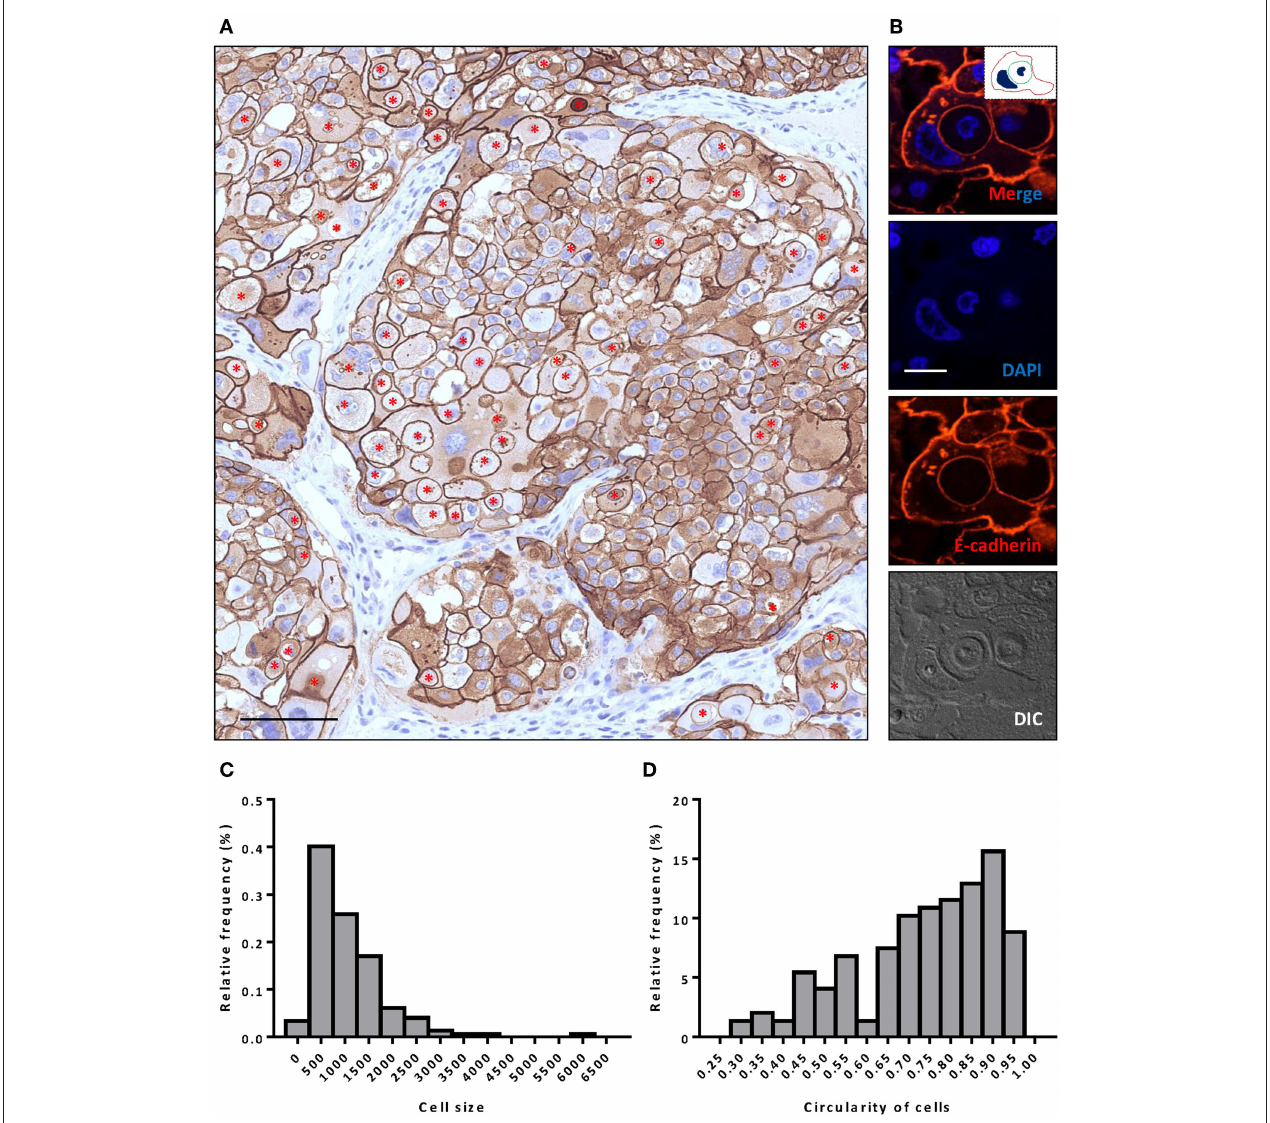
FIGURE 1 | Extensive CIC formation in heterogeneous cancer tissue. (A) Representative image for HER-2 staining. Inner cells of CIC structures are indicated with red asterisks. Scale bar: 100 µ m. (B) Representative image for a typical CIC depicted with E-cadherin staining. Inserted picture of the top merged image is a schematic cartoon for the indicated CIC structure. Scale bar: 20 µ m. (C,D) Histogram plots of cell size (C) and cell circularity (D) for (A)